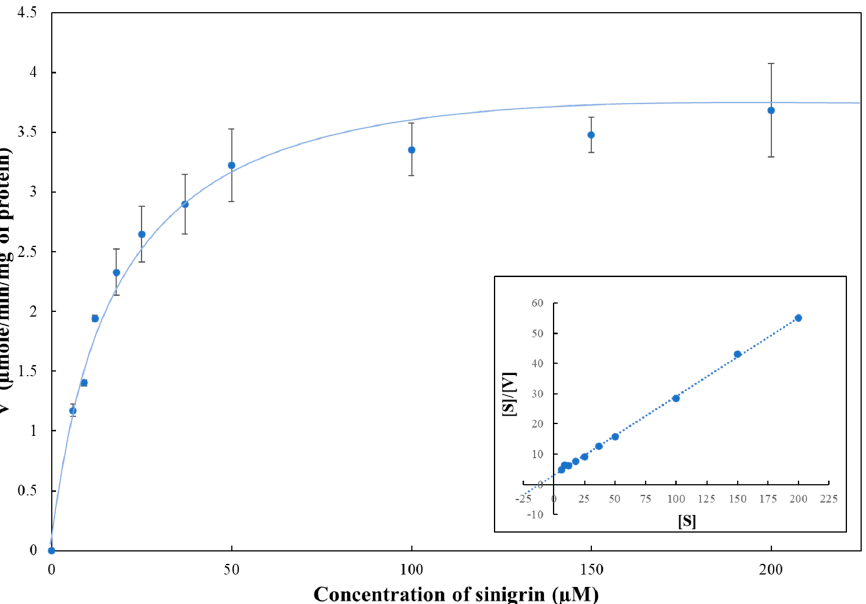
Figure 4. Enzyme activity assay of MYR-coreSA fusion protein using sinigrin as substrate at 37 °C and pH 7. Kinetic plot of specific activity V (µmol/min/mg protein) versus substrate concentration (µM). The Hanes plot (shown as inset) was employed to estimate K m and V max .